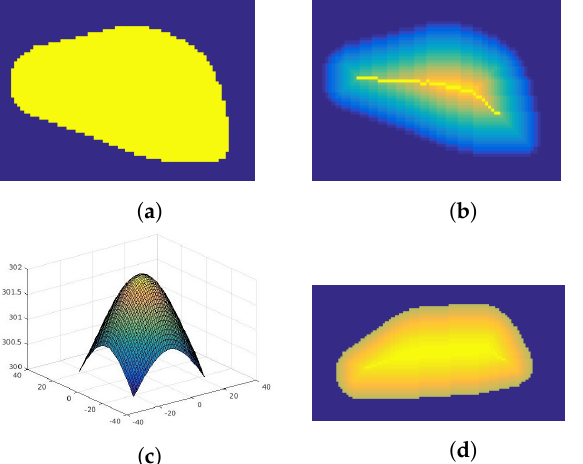
Figure 2. Stages of texture simulation: ( a ) the initial shape, ( b ) shape after skeletonization with linear labeling of each iteration, ( c ) choosing the distribution for labeling, and ( d ) applying distribution to a thinned